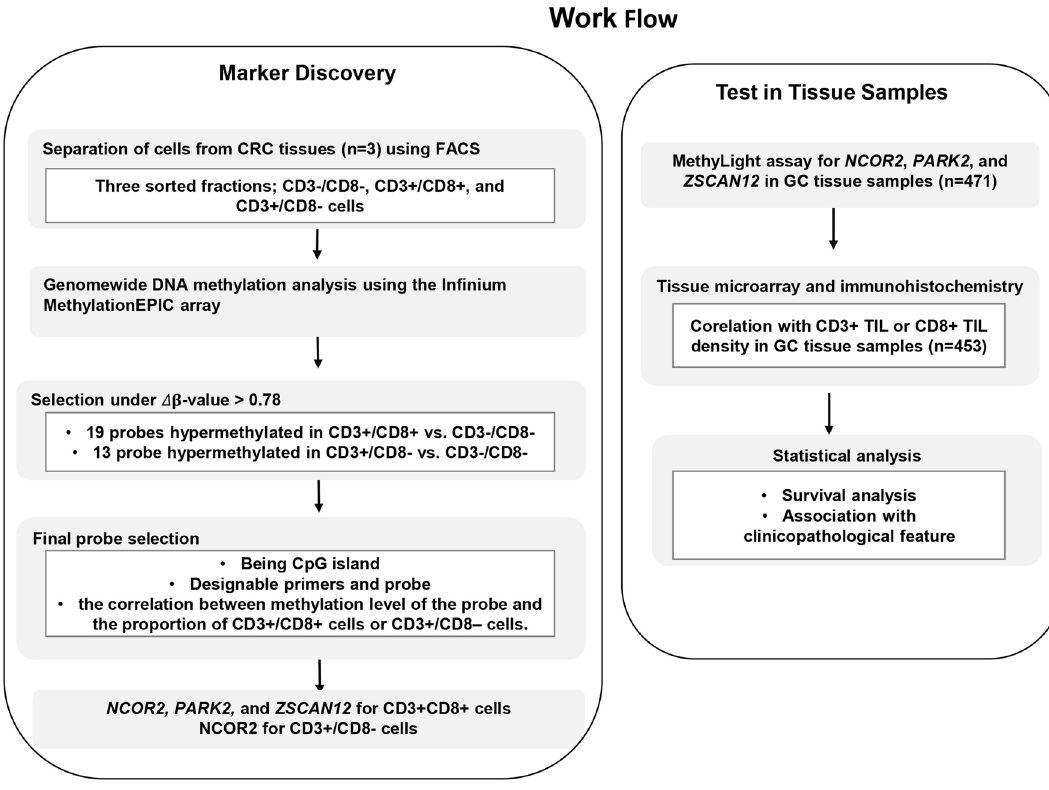
Figure 1. Overview of study workflow from marker discovery to verification in tissue samples. The process of selection of candidate DNA methylation markers and their verification in detection of CD8-positive T cells in tissue samples from patients with GC and their correlation with survival and clinicopathological features were schematically